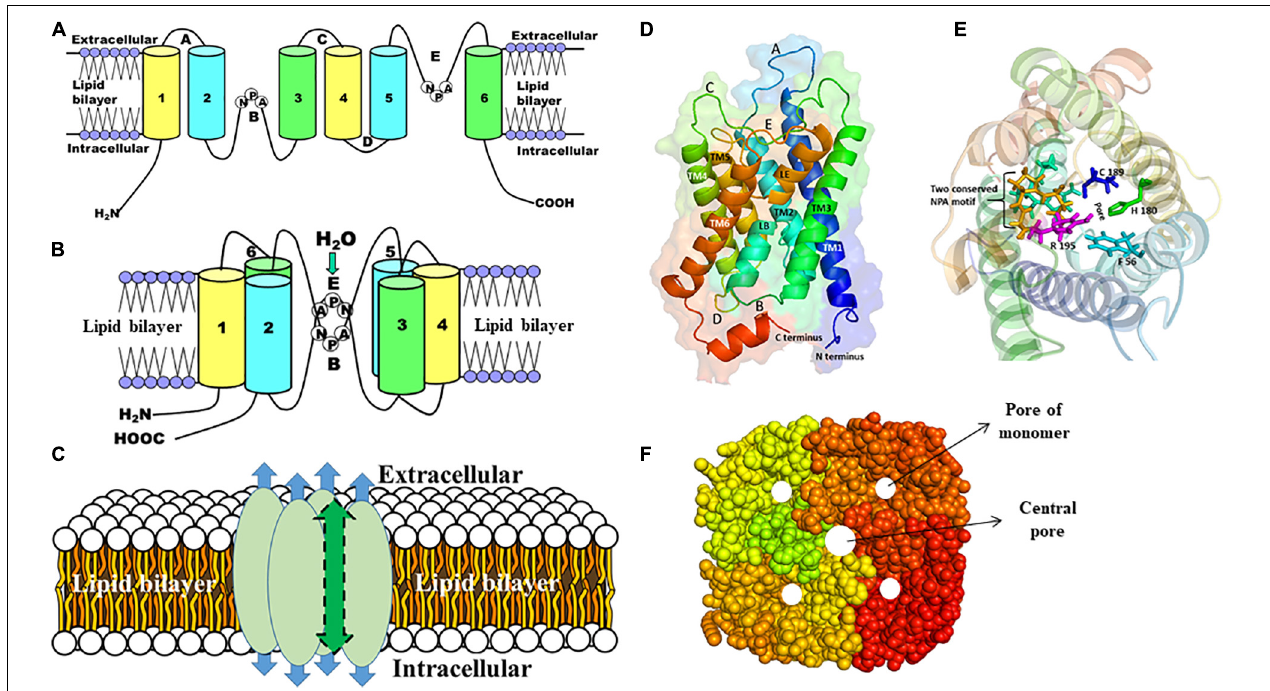
FIGURE 2 | The structure of AQP monomer and homotetramers. A schematic representation of the general structures of AQP is shown (A–C) . (A) Each AQP monomer has six transmembrane domains (1–6) spanning the plasma membrane, which are connected with five loops (A–E). (B) Two conserved NPA motifs in loops B and E are juxtaposed oppositely to form the channel through which molecules are passed. (C) Each AQP monomer contains independent pore (shown as blue arrow) and the monomers are assembled as tetramers to form a central pore (shown as green arrow). (D) Side view of the structure of the human AQP1 monomer, which shows six transmembrane α -helices (TM1-6) including pseudo TM (LE and LB) that are connected with five different loops (A–E). (E) The top view of the human AQP1 is shown. The residues (F56, H180, C189, and Arg195) in the ar/R constriction and two NPA motifs (yellow and cyan) are shown in sticks. (F) The top view of the AQP homotetramers with filled amino acid residues is shown. The pore of each monomer and the central pore of the homotetramers are shown as white